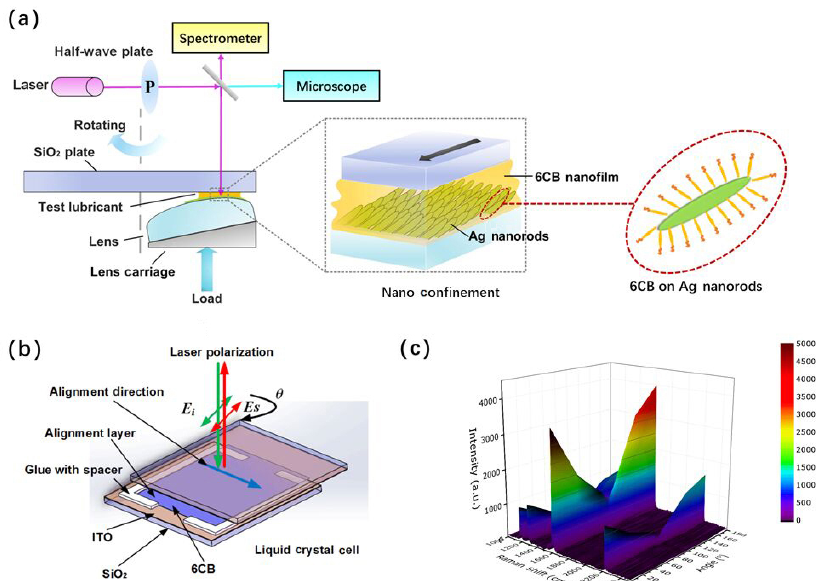
Fig. 1 (a) Schematic of the experimental apparatus and 6CB in the nanoconfinement, (b) illustration of an LC cell; θ is the angle between the direction of the polarized laser and the alignment direction of 6CB, (c) Raman spectra of 6CB recorded with a laser polarized at different angles, where θ is marked for each